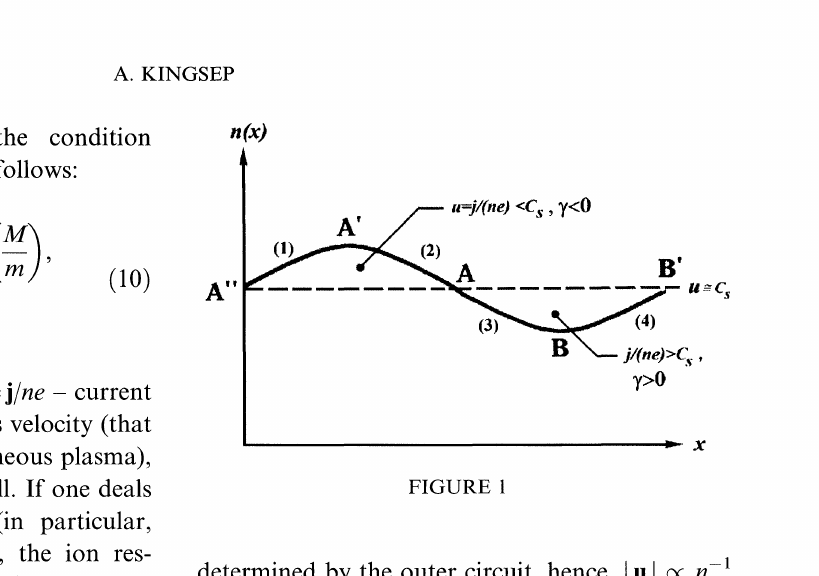
determined by the outer circuit, hence, ]u] n